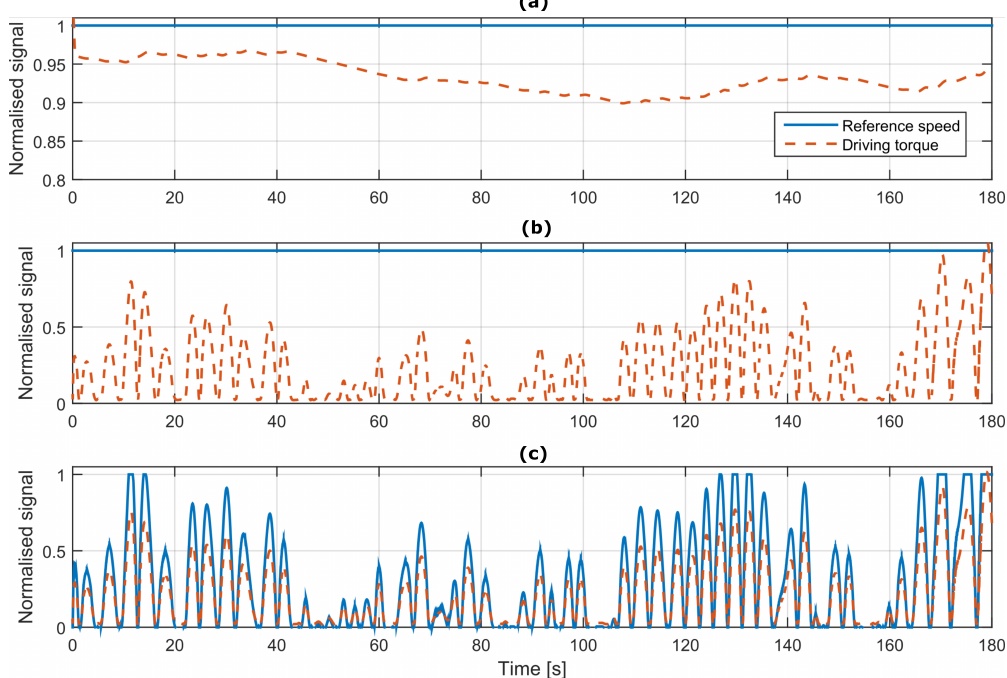
Figure 11. The three signals based on realistic PTO systems: constant torque and rotational speed ( a ), variable torque and constant rotational speed ( b ) and variable torque and rotational speed ( c